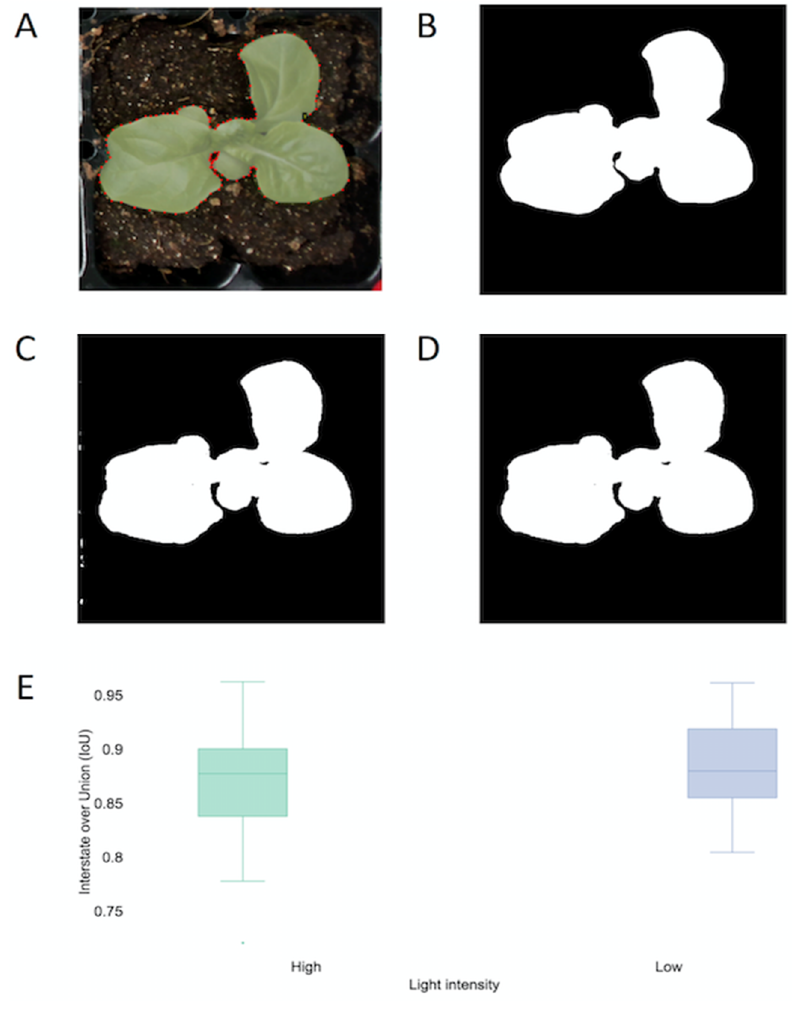
Figure 1. Summary of extract projected area (PA) between ground truth (GT) and U-Net model at two lighting intensities. Thirty-five images were selected at various plant and growth stages in a random manner. ( A ) Manual labeling of the leaf area of a selected lettuce image. ( B ) Binary transformation (PA) of GT for the lettuce image. ( C ) Binary transformation (PA) of the selected image with U-Net. ( D ) Binary transformation (PA) with U-Net using the error correction method. ( E ) Comparing accuracies of extract PA between the GT and U-Net models using the Jaccard index.